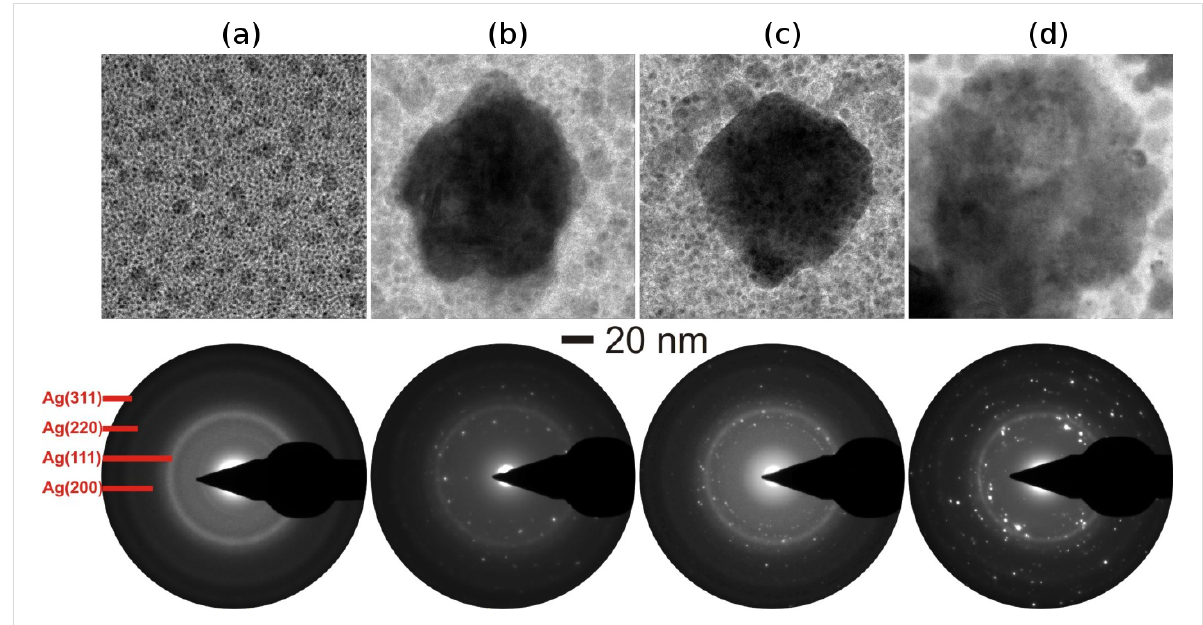
Figure 5: Microstructural changes in the TiO 2 matrix of the nanocomposite film with MVF (Ag) ≈ 15% induced by 100 MeV Ag 8+ ions. Bright field TEM images corresponding to: (a) pristine film, (b) 1 × 10 12 ions/cm 2 , (c) 3 × 10 12 ions/cm 2 , (d) 1 × 10 13 ions/cm 2 . The selected area electron diffraction patterns with respect to pristine film (a) and different irradiation fluences are shown below. Crystallinity of the TiO 2 matrix has been observed as a result of the reflections corresponding to the metrics from brookite and rutile structures from the SAED patterns from (b) to